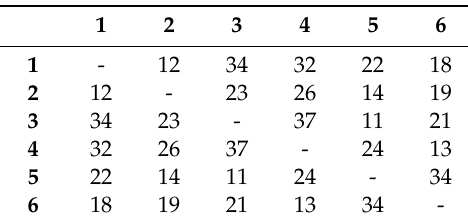
Table 3. Distance from farm to farm.